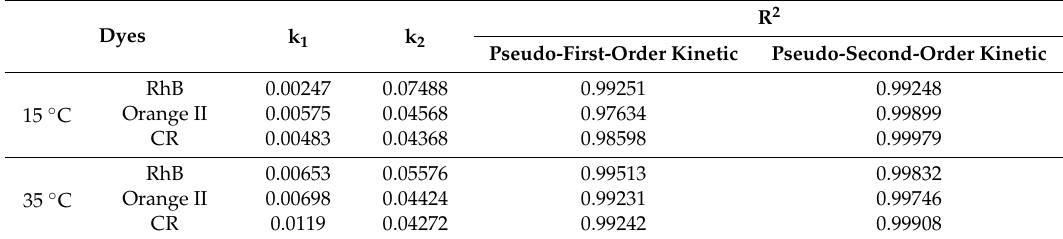
Figure 7. Pseudo-first-order plots of dye adsorption over Fe-MOFs. Table 1. Kinetic constants (k) with correlation coefficients (R 2